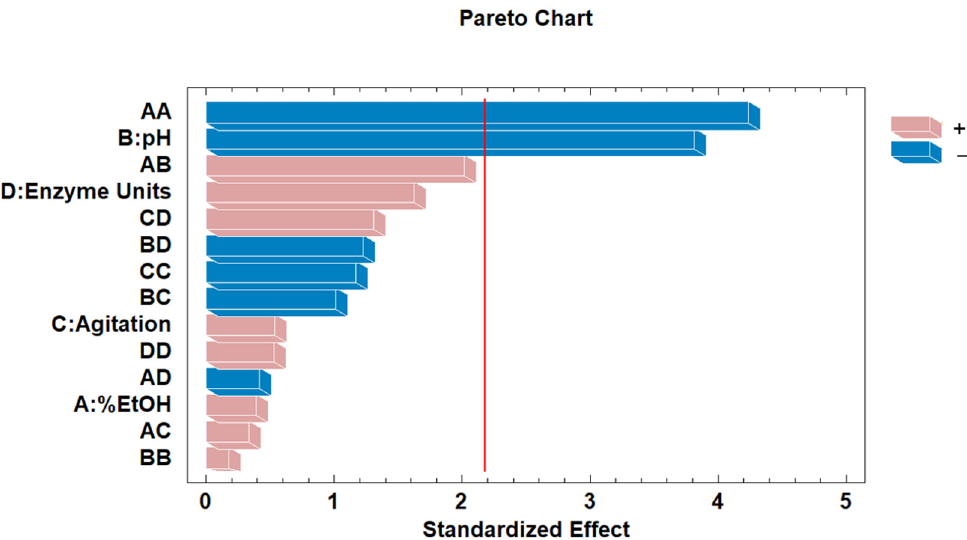
Figure 3. Pareto Chart from the BBD–RSM design corresponding to the extraction of the anthocyanin. A: %EtOH in the solvent; B: solvent pH; C: agitation; D: units of enzyme per gram of sample.